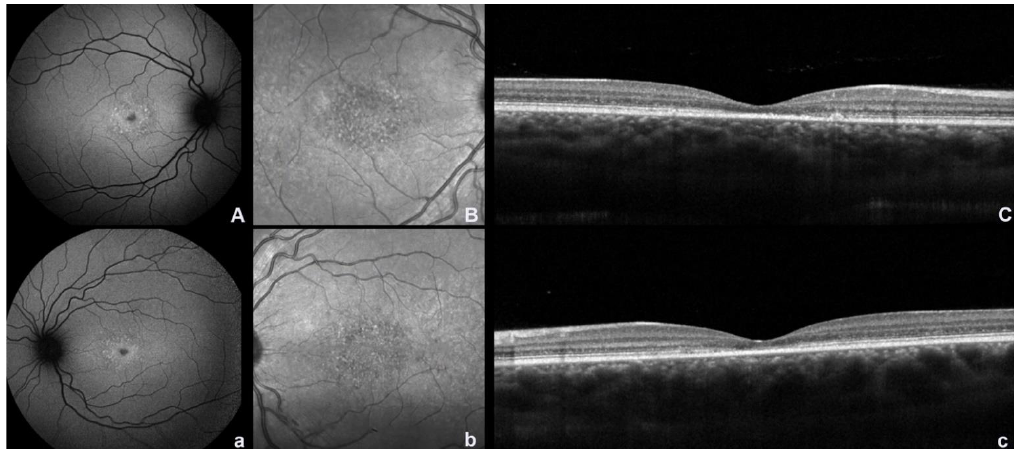
Figure 1. Fundus autofluorescence (FAF), near-infrared reflectance (NIR), and spectral domain optical coherence (SDOCT) images in a patient with bilateral molecularly confirmed ABCA4 Stargardt disease in the early stage. ( A , a ) FAF image showing a small, nascent region of macular hypoautofluorescence with a surrounding ring of hyperautofluorescence; ( B , b ) NIR image showing an area of dotted hyper– hyporeflectivity of the macula; ( C , c ) SDOCT scan showing foveal alterations of the outer retinal layers (uppercase and lowercase letters indicate the right and left eye,